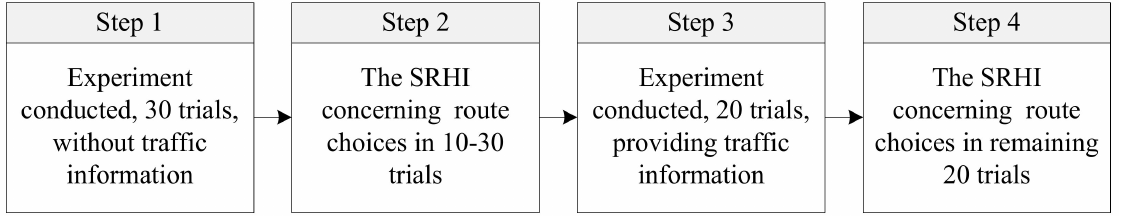
Figure 2. The design of the experimental procedure.